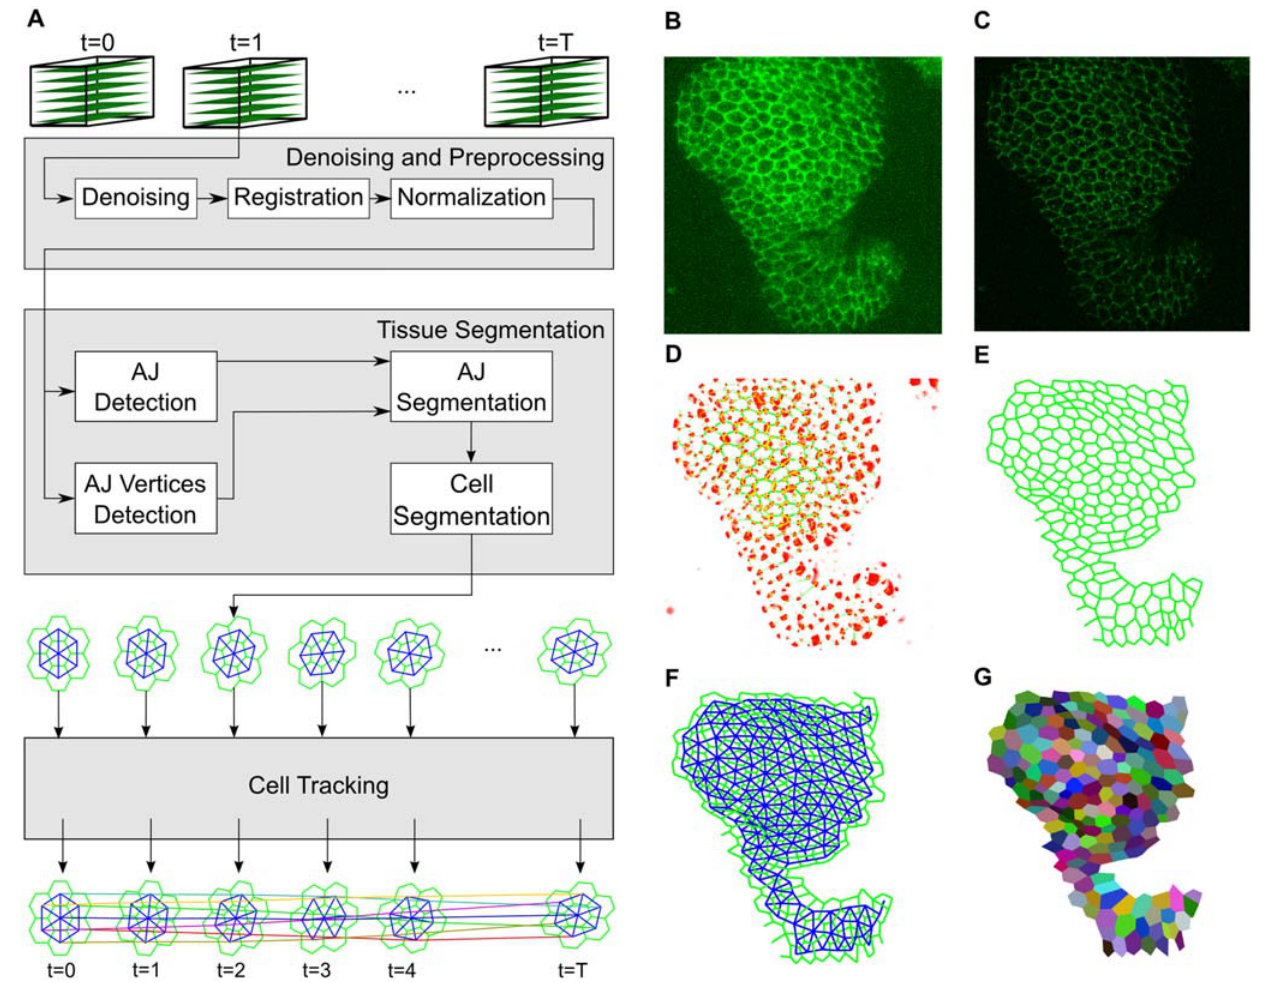
Fig 1. The developed system for the preprocessing, segmentation and tracking of epithelial cells. A) Schematic of the computational pipeline from the acquisition of 3D time lapse data to image preprocessing, cell segmentation and tracking. After segmenting the cells, we define symbolically their structure using a planar graph connecting detected AJ vertices with edges (green). Then we identify the cells in the tissue as the faces of the AJ graph and build the Cell graph to describe cell connectivity (blue). Finally, we establish correspondence between cells among frames (colored lines connecting cell centroids) obtaining cell trajectories. (B-G) Part of an epithelium of a Drosophila leg at early pupal stages. This tissue dramatically narrows and elongates at this stage to generate a narrow and hollow cylinder while the epithelium at presumptive joints invaginates. B) Maximum intensity projection of an image stack through the leg epithelium marked with E-cad :: GFP to highlight cell outlines. Distal up, narrow region — presumptive joint; wider regions part of the presumptive segment. C) Projection of the denoised and deconvoluted volume. D) The output of the filters employed to detect AJs (green) and AJ vertices (red). E) AJ graph representing the AJs structure. F) Cell graph representing neighborhood relationships among cells in the tissue. G) Polygonal representation of the cells, colored according to assigned temporal identifiers.